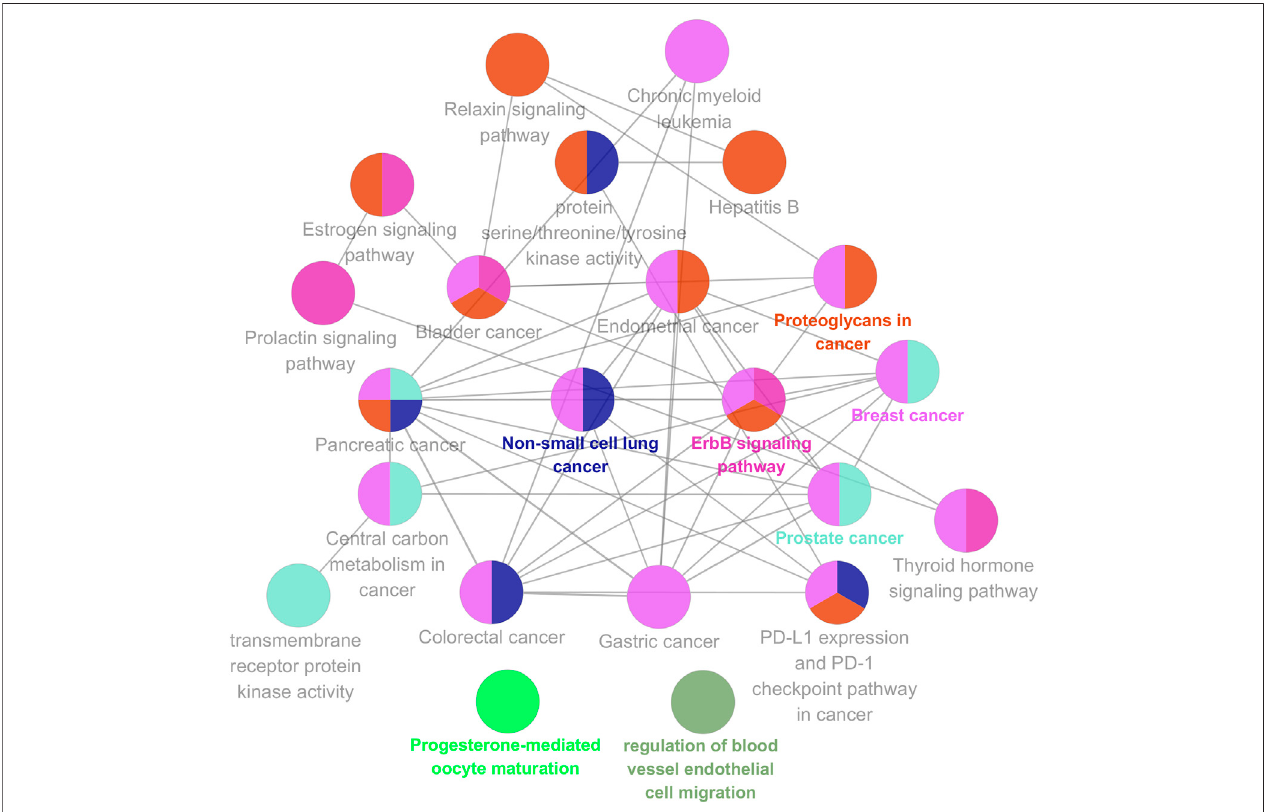
FIGURE6| KEGGanalysisusingtheClueGOplug-in.KyotoEncyclopedia ofGenesandGenomespathway analysesofthepotentialtargetsofShanCiGuagainst non-small cell lung cancer by the ClueGO plug-in. Each node is a representative enrichment pathway. The nodes indicate the number of genes shared between pathways. The color represents the enrichment classi fi cation of the